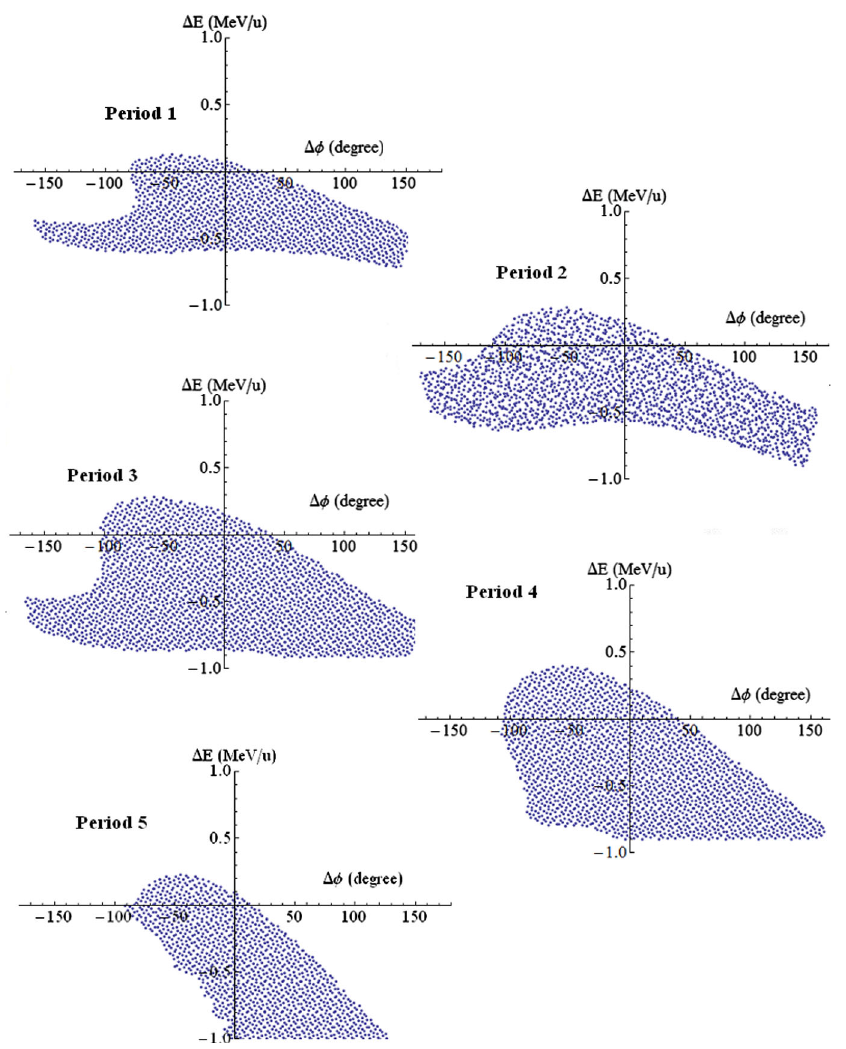
FIG. 9. Longitudinal acceptance of the periods using particle tracking code GPT